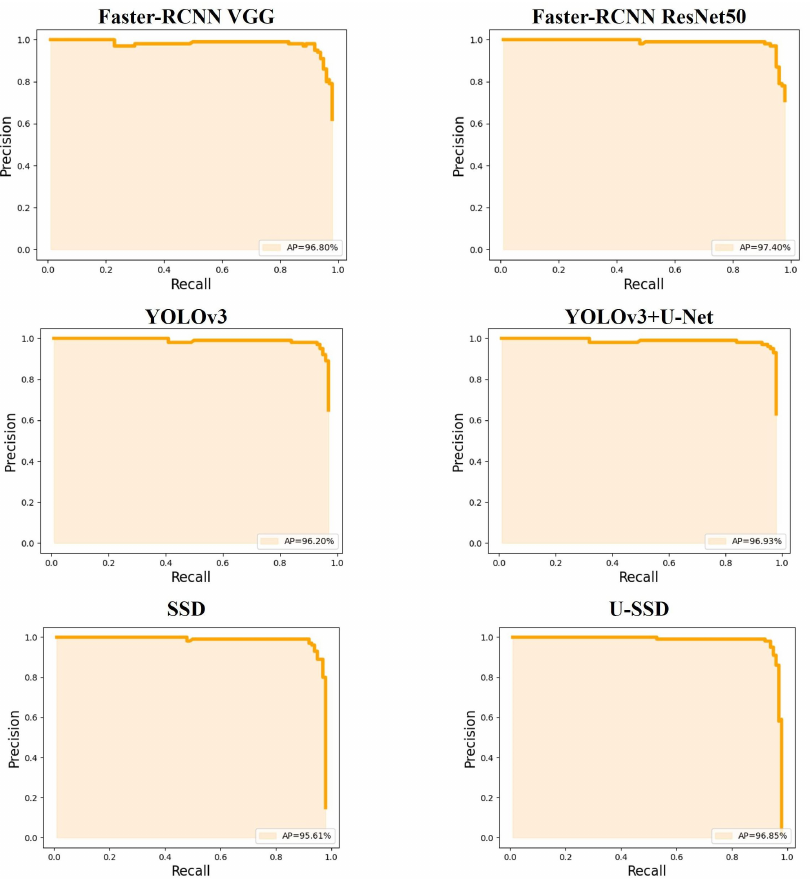
Figure 6. P-R curve at IoU = 0.5 on our dataset. Table 2. The comparison at IoU = 0.5 on our